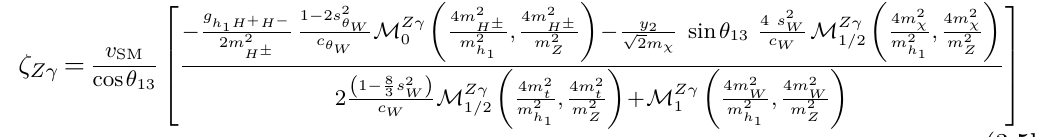
Figure 2. Contours satisfying the constraint µ in (a) m χ − | y 2 | plane corresponding to three choices of charged Higgs mass and (b) m χ − m plane corresponding to four choices of | y 2 |